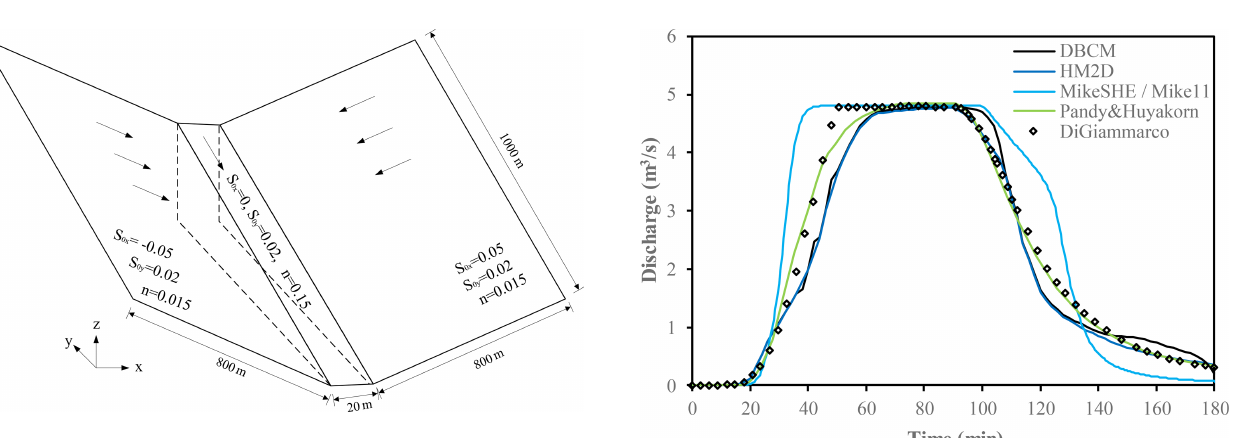
Figure 10. Diagram and dimension of the tilted V-shaped catch- ment.